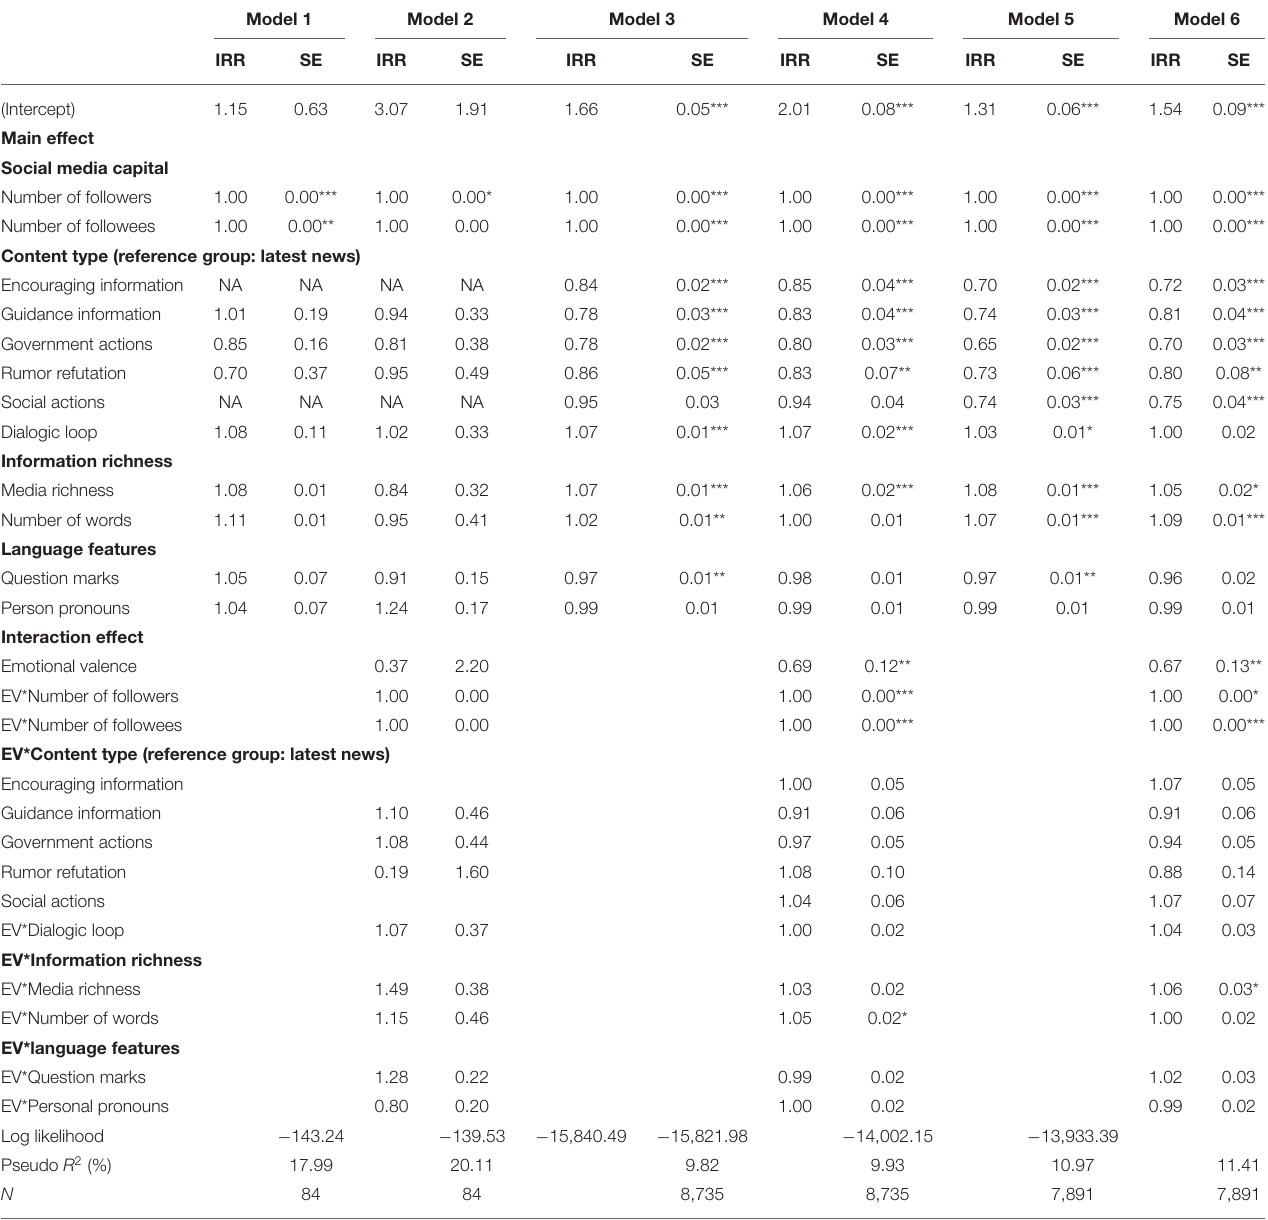
TABLE 3 | Predicting CEGSM in the three stages of the COVID-19